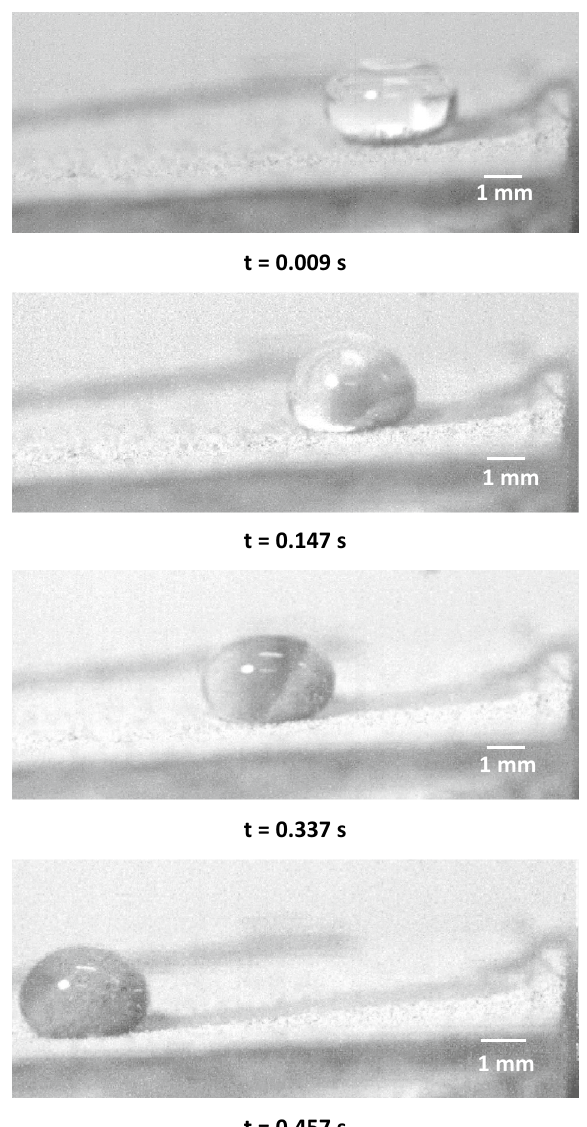
Figure 10. High-speed camera images of water droplets over dusty micro-post array surfaces at different time